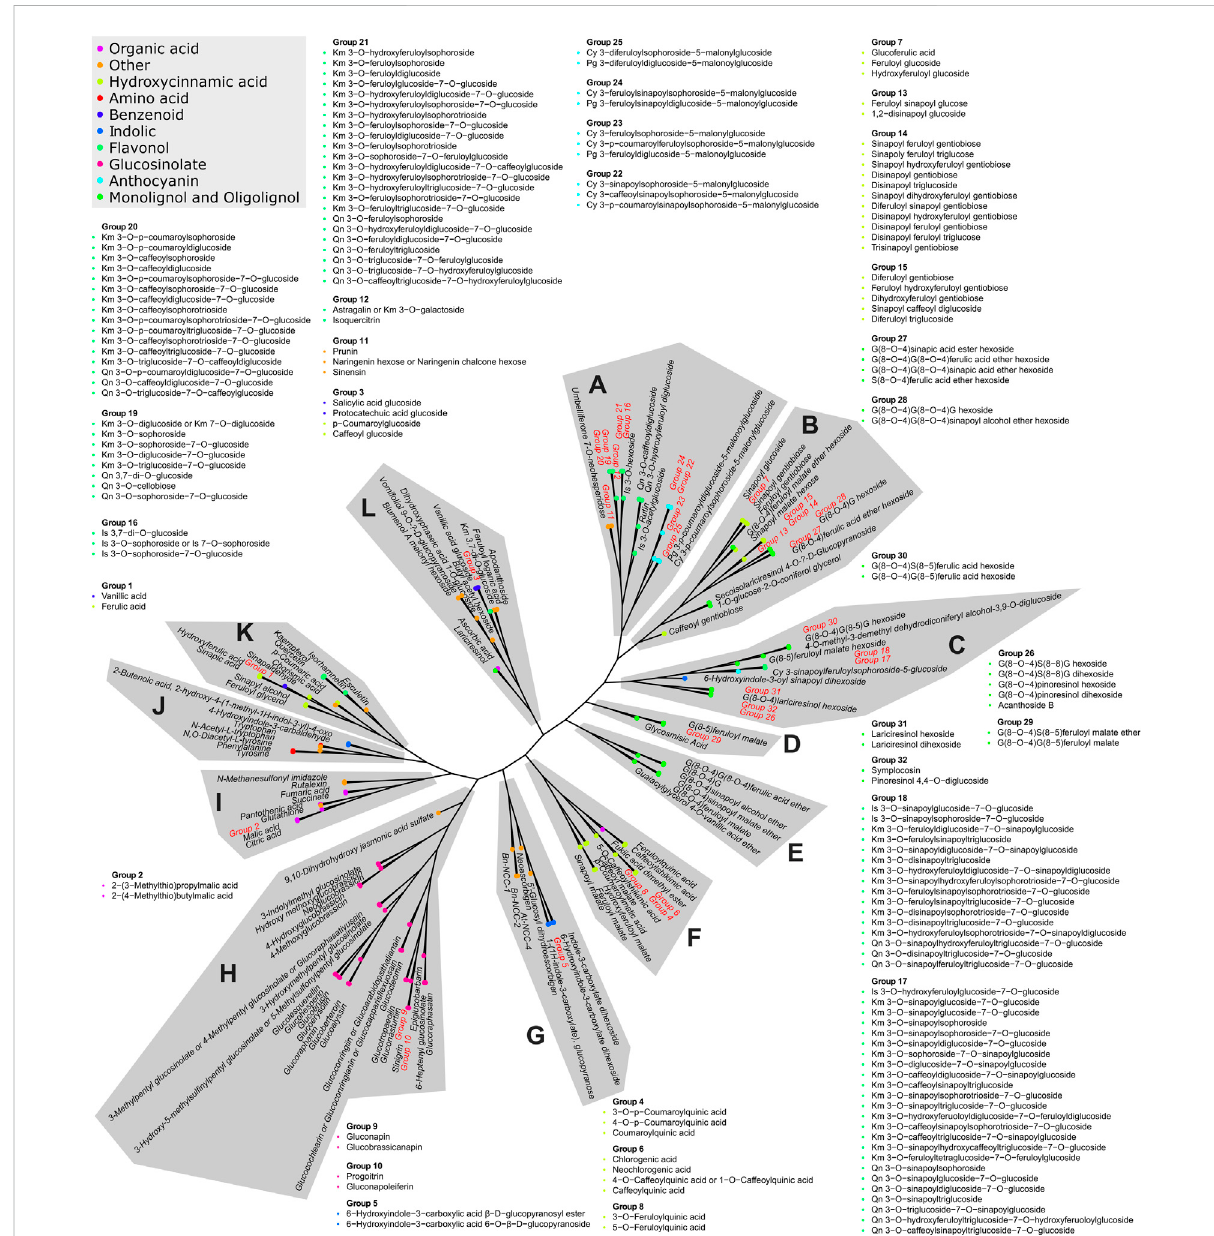
FIGURE 2 Tanimoto similarity-based clustering tree representing the chemical complexity of the obtained metabolic pro fi les. The distance matrix is clustered using the complete linkage method. The classi fi cation of chemical compounds, according to the Dictionary of Natural Products (https:// dnp.chemnetbase.com), is represented by the color code. Twelve major compound cluster groups are marked by letters A to L. Metabolites exhibiting identical fi ngerprints are represented by numbered groups from 1 to 32. Members of all groups are listed in the proximity of their original